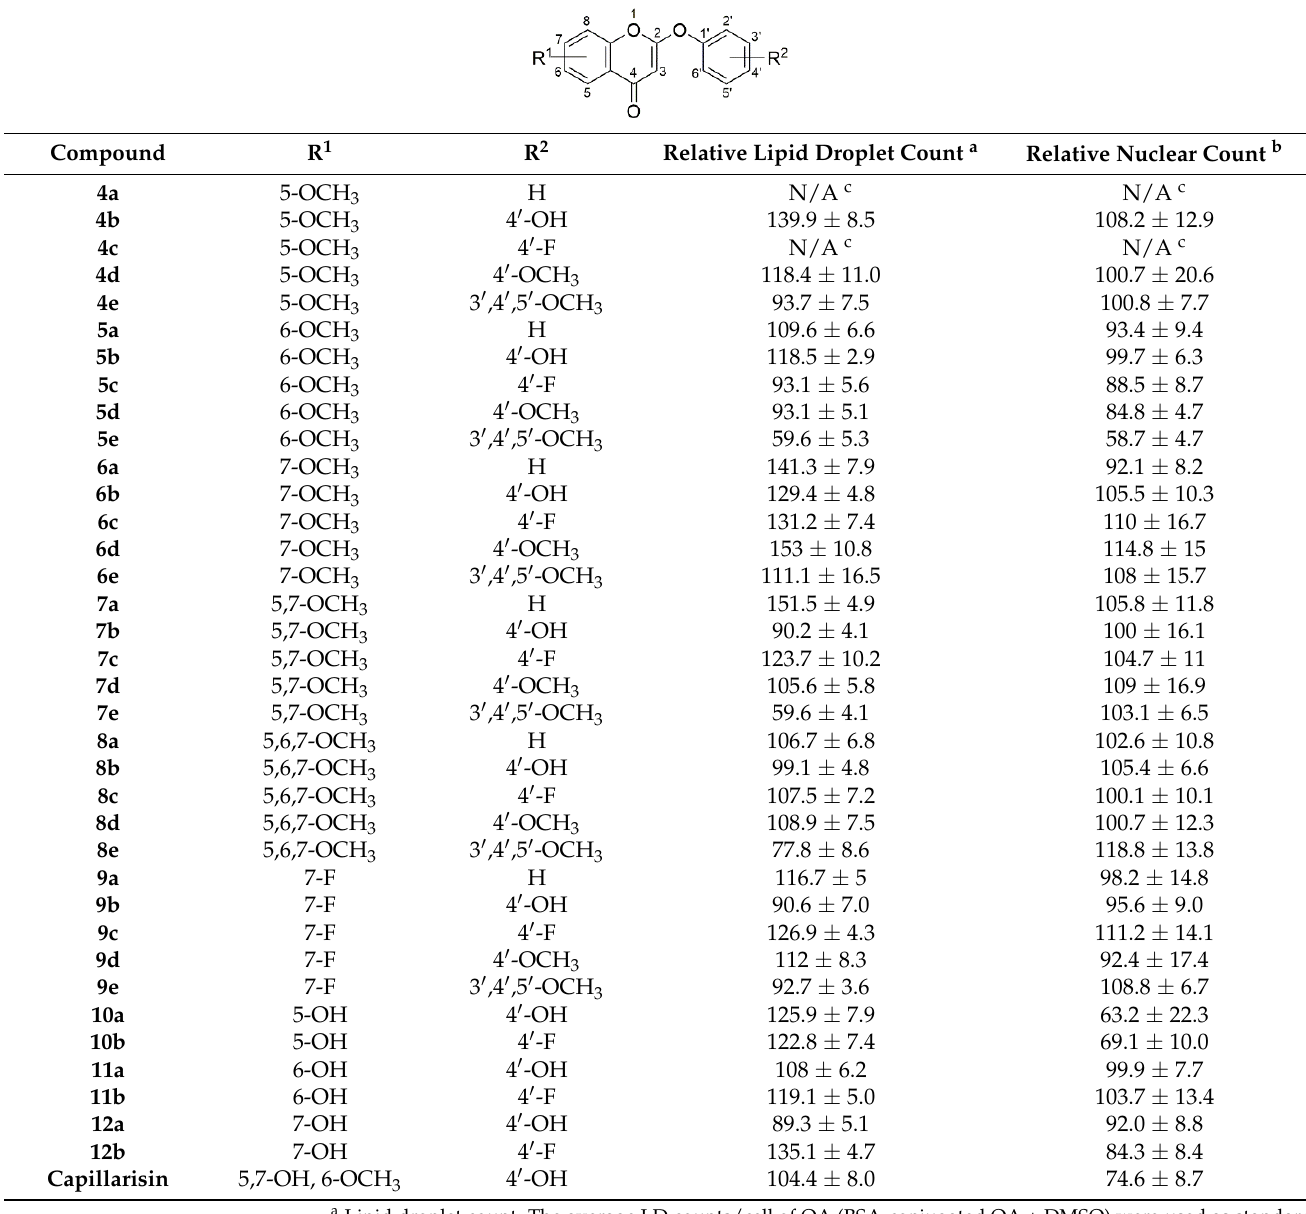
a Lipid droplet count: The average LD counts/cell of OA (BSA-conjugated OA + DMSO) were used as standard for 100 % of fatty loading in Huh7 cell line. The pure compound concentration is 40 µ M. b Relative nuclear count: The average nuclear counts/cell of OA (BSA-conjugated OA + DMSO) were used as standard for 100 % of fatty loading in Huh7 cells. c Easily decomposed under normal storage